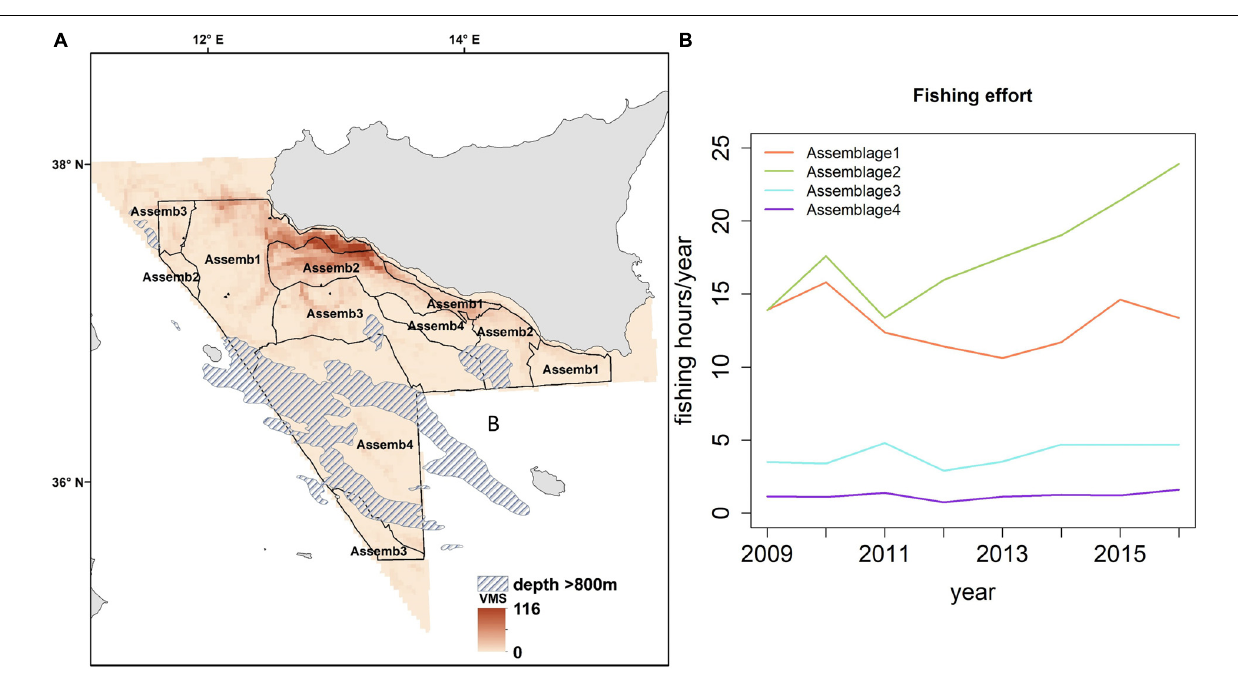
FIGURE 7 | (A) Spatial distribution of the demersal assemblages in the central Mediterranean Sea based on data from 2002 to 2016. (B) Temporal trend of the fishing effort between 2009 and 2016 in terms of number of fishing hours/year in each of